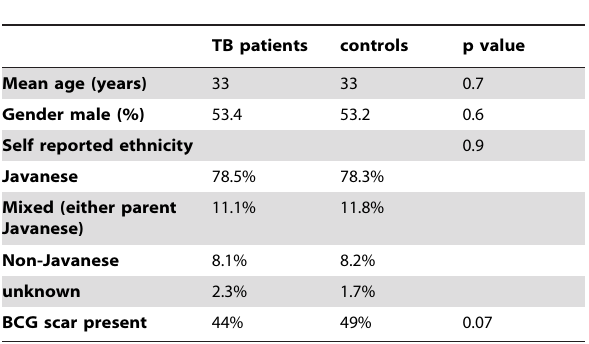
Table 2. Demographic information of the study population.